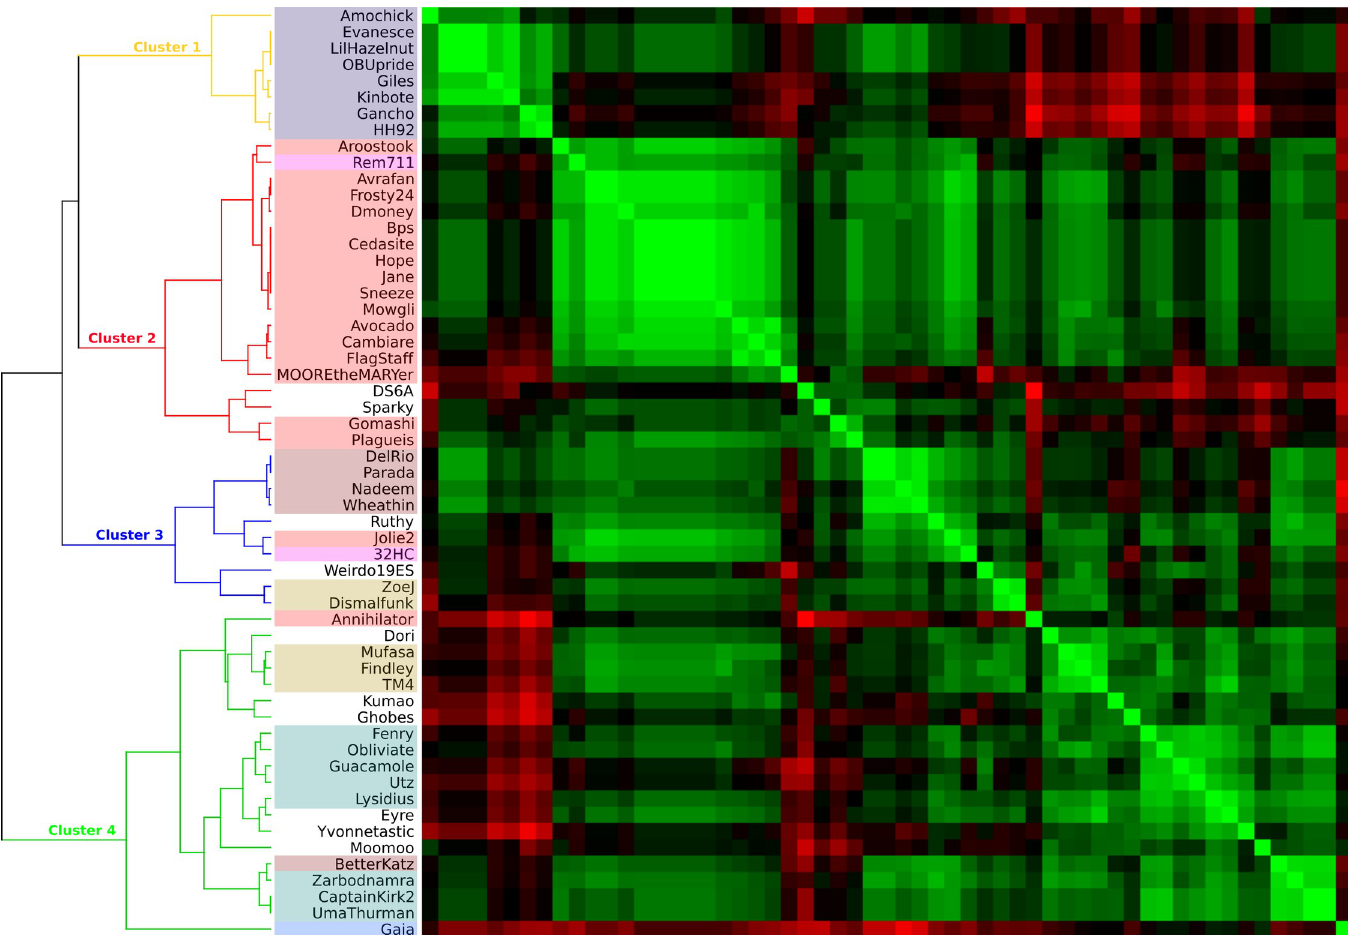
Fig 8. Clustering analysis of the relative synonymous codon usage values. RSCU values obtained by MEGA X where used to construct a similarity matrix. Hierarchical clustering and heatmap representation was performed in TreeView3 program. The four main clusters are depicted in the dendrogram at the left of the heatmap.